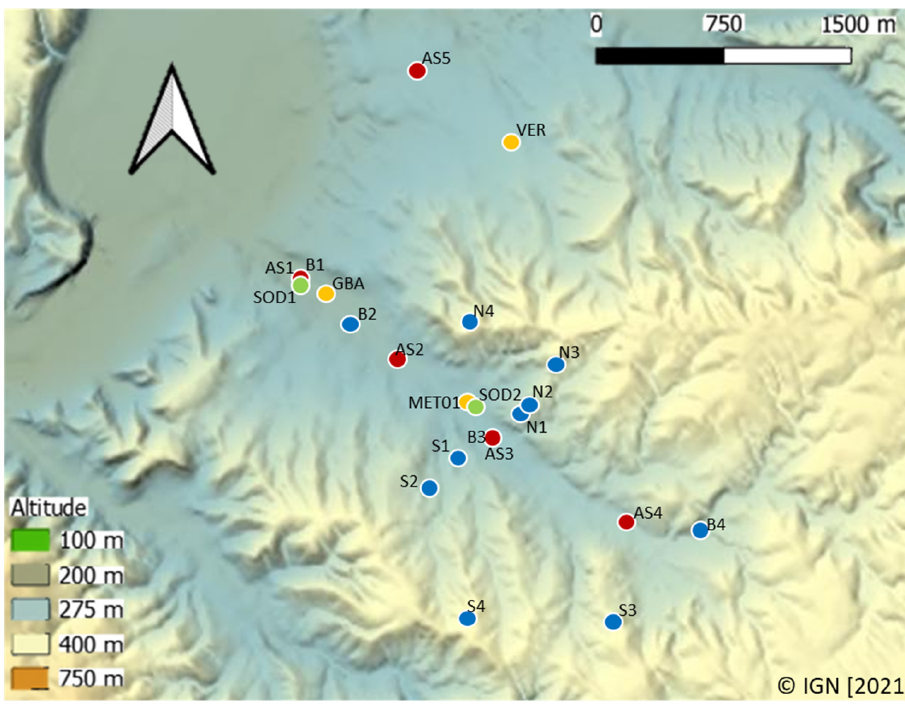
Figure 2. Location of the observation sites: the permanent platforms are the 110 m GBA tower, the Metek sodar (SOD2), and the MET01 weather station. The other platforms were installed during the KASCADE 2017-campaign: SOD1 is the Remtech sodar, AS1 to AS5 are sonic anemometers, and B1 to B4, S1 to S4, and N1 to N4 are the LEMS stations installed at the bottom and on the southern and northern sidewalls of the CV, respectively. The color scale represents the topography of the terrain.